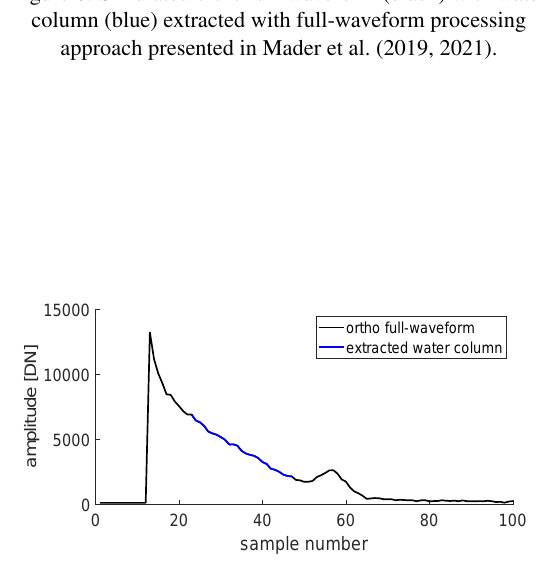
Figure 7. Ortho full-waveform (black) resulting from the volumetric evaluation of real measurement data (Richter et al., 2021b; Mader et al., 2022) and water column (blue) extracted with full-waveform processing approach presented in Mader et al. (2019,